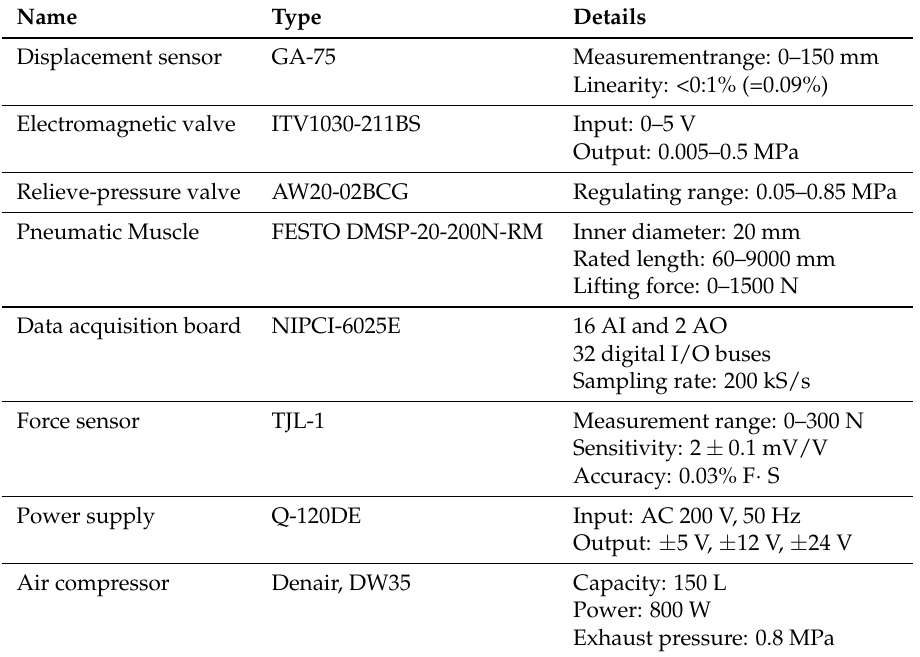
Table 1. List of main equipment in the experiments.